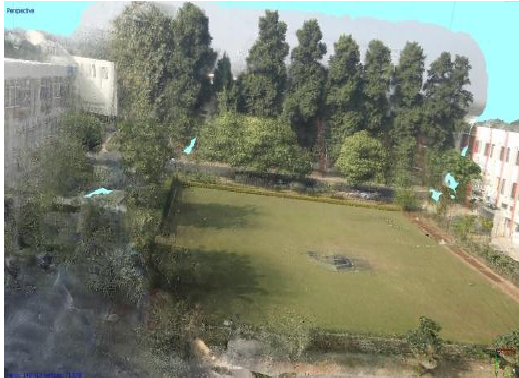
Figure 16: Textured 3D model of Lawn area (park) at civil